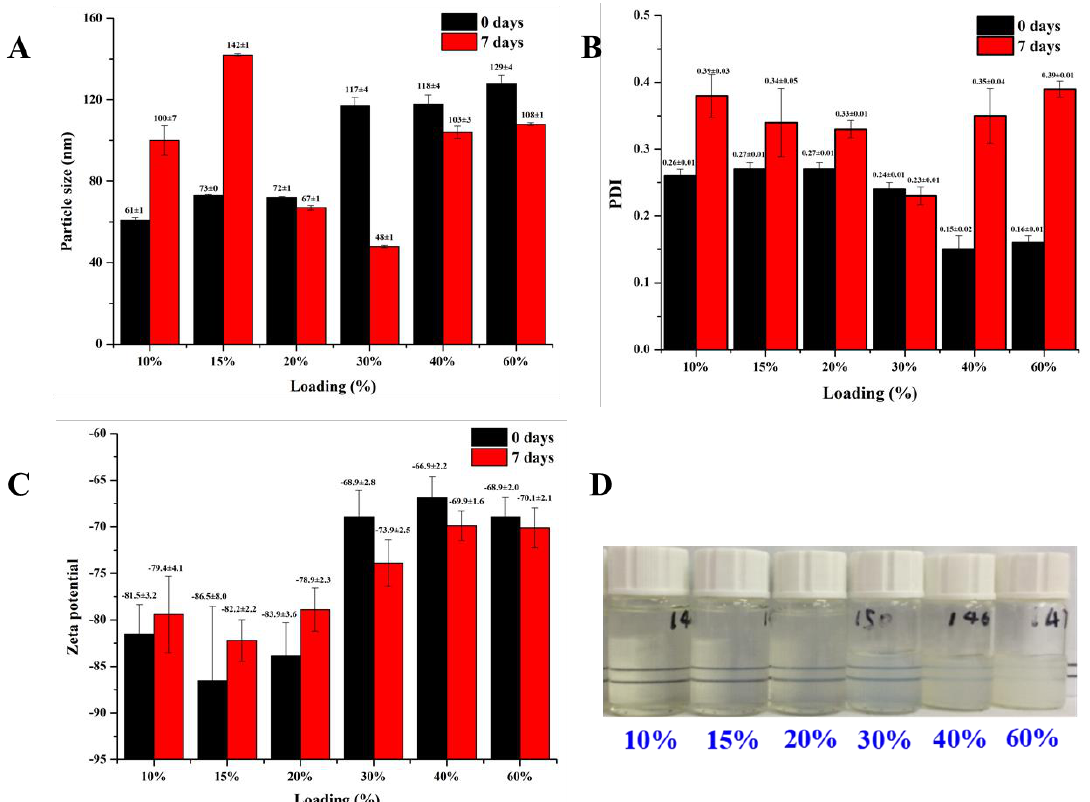
Figure 2. Effects of α -TOC loading, in percentages of sodium oleate mass, on ( A ) particle size, ( B ) polydispersity index (PDI), ( C ) zeta potential before and after seven-day ambient storage at 25 °C, as well as ( D ) appearance of fresh dispersions. Error bars are standard deviations ( n = 3).